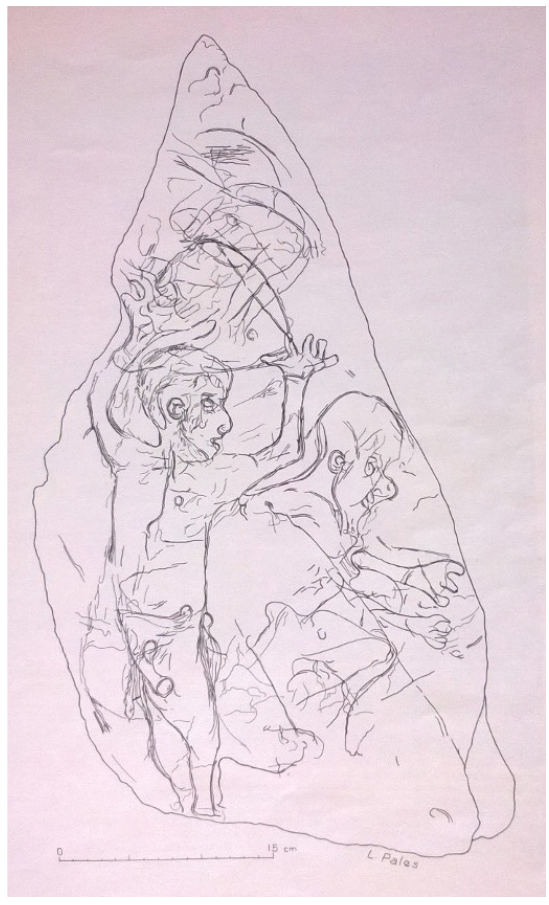
Figure 22. Group δ, examples of Hand δ1: Obs. 60(I-II) (from Pales, 1976).